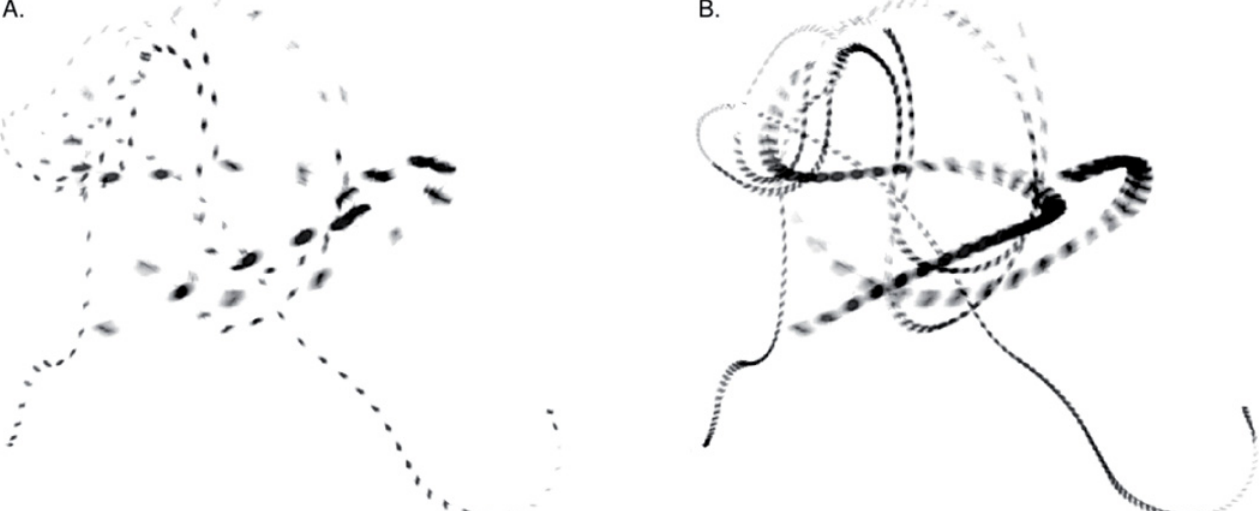
Fig 3. The flight paths of two blue bottle flies ( Calliphora vomitoria ) sampled from high-speed video (S1 Movie): A) at the rate of the visual system of a human (40 frames/s) and B) at the rate of a pied flycatcher (120 frames/s) at a light intensity of approximately 500 cdm -2 . The flycatcher refreshes visual input almost three times faster, resulting in a much more detailed view of the flight paths of the